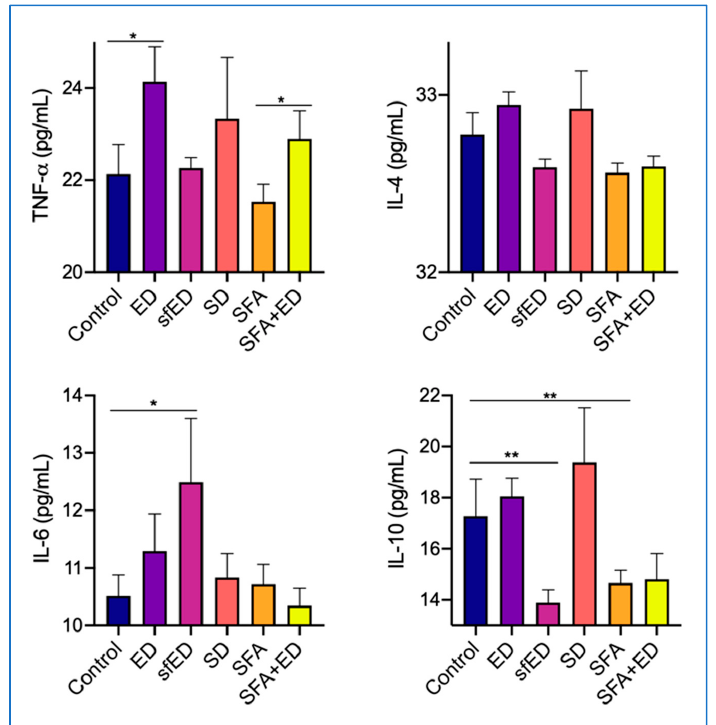
Figure 5. Serum cytokine concentrations. The mice received no liquid intervention (control), Mother (ED), sugar-free Mother (sfED), Coca-Cola (SD), saturated fat enriched diet (SFA) or SFA with ED (SFA + ED) for 13 weeks. Serum concentrations of inflammatory cytokines TNF- α , IL-4, IL-6 and IL-10 were measured using a commercial cytokine beads array kit. Interpolated values are presented as mean ± SEM for each cytokine. Statistical analysis was performed using a one-way ANOVA with Fisher’s LSD post hoc analysis ( n = 10; * p < 0.05, ** p<0.005).